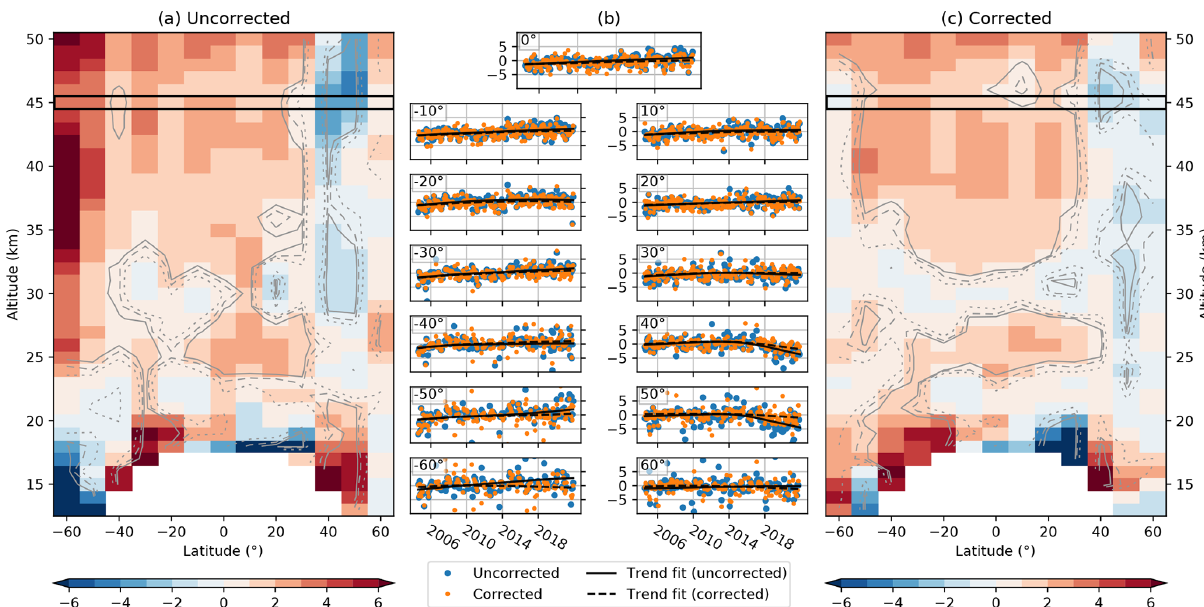
Figure B1. Differences in the SOS and MLS relative anomalies. Panel (a) shows the SOS minus the MLS relative anomaly differences for the SOS composite, including the original OSIRIS and SAGE III/ISS data, while (c) shows the same for the SOS version that includes the sampling-corrected OSIRIS and SAGE III/ISS ozone. The units represent the percent change in ozone between 2005 and 2021, while the dotted, dashed, and solid contours show the 80%, 90%, and 95% confidence intervals, respectively. (b) Relative anomaly difference time series and DLM trend fits at